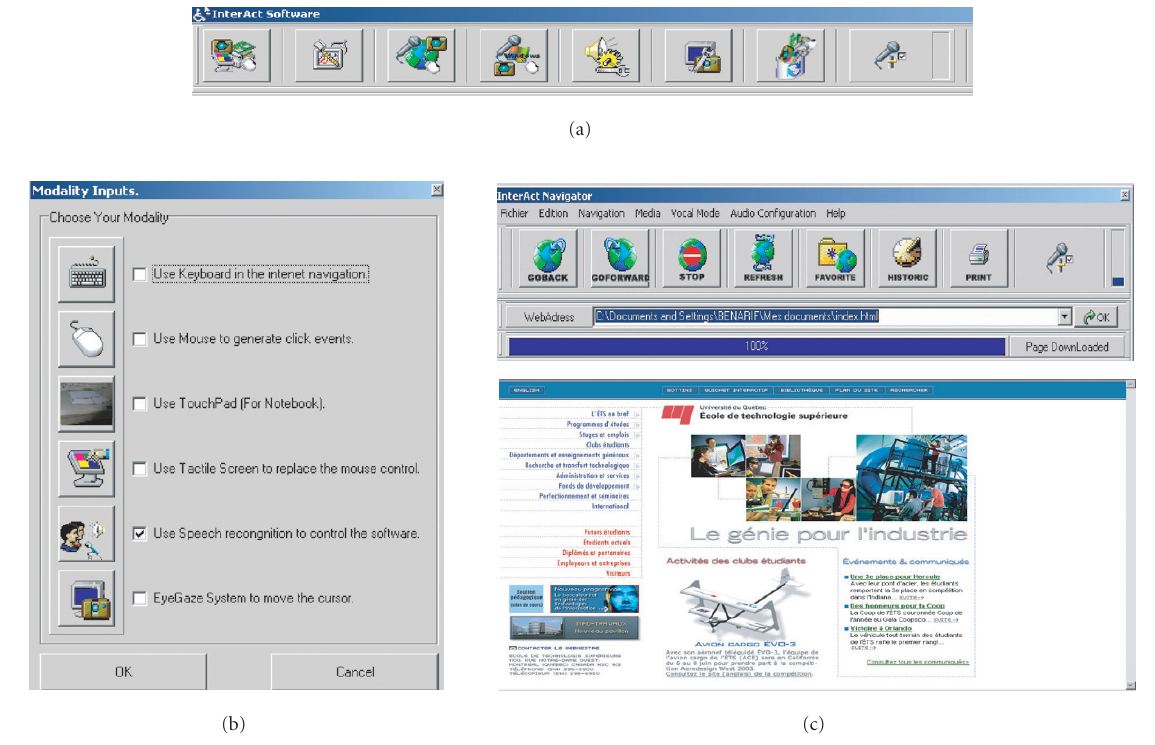
Figure 13: (a) The intuitive menu of Interact Software. (b) Input modality interface in Interact Software. (c) The Interact navigator: a user-friendly Web navigator with functionalities adapted to predefined eye gaze and/or voice